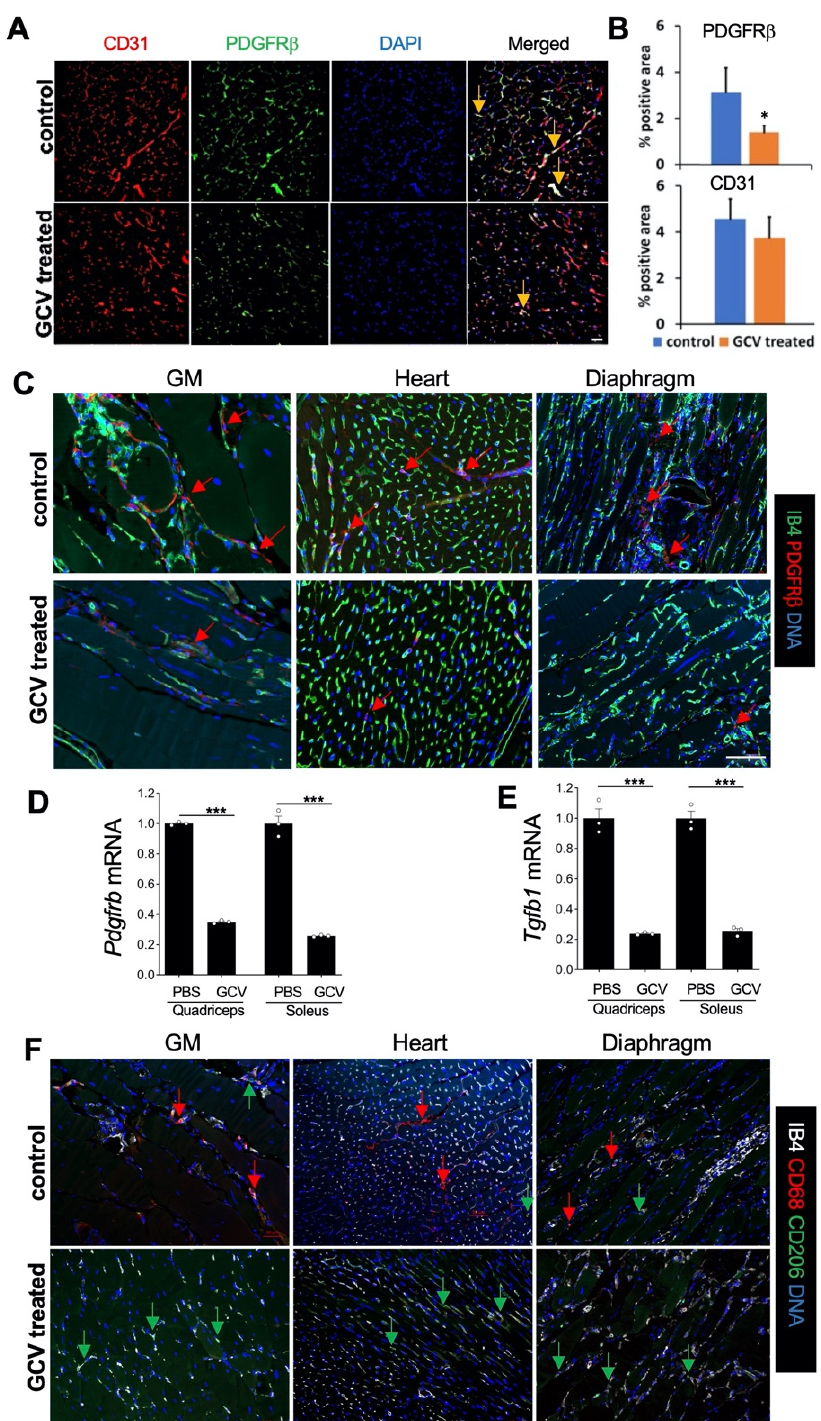
Figure 2. Ablation of Pdgfrb + lineage MSCs in dystrophic muscle. ( A ) Representative IF (from n = 5) on gastrocnemius (GM) of Pdgfrb-TK mice showing that GCV treatment depletes PDGFR β + cells associated with CD31+ endothelium. ( B ) Data from ( A ) quantified based on the analysis of n = 10 view fields. ( C ) Representative IF on indicated muscle tissues from mdx/Pdgfrb-TK mice showing that GCV treatment ablates PDGFR β + cells (red arrows) associated with the endothelium stained with isolectin B4 (IB4). ( D ) RT-PCR showing the effect of Pdgfrb + lineage cell ablation on the relative expression of Pdgfrb (normalized to 18S RNA ), n = 3. ( E ) RT-PCR showing the effect of Pdgfrb + lineage cell ablation on the relative expression of Tgfb1 (normalized to 18S RNA ) n = 3. ( F ). Representative IF on indicated muscle tissues from mdx/Pdgfrb-TK mice showing that GCV treatment reduces the frequency of CD68+ macrophages (red arrows) but not CD206+ macrophages (green arrows). * p < 0.05; *** p < 0.01 (Student’s t -test). Scale bar: 50 µm.